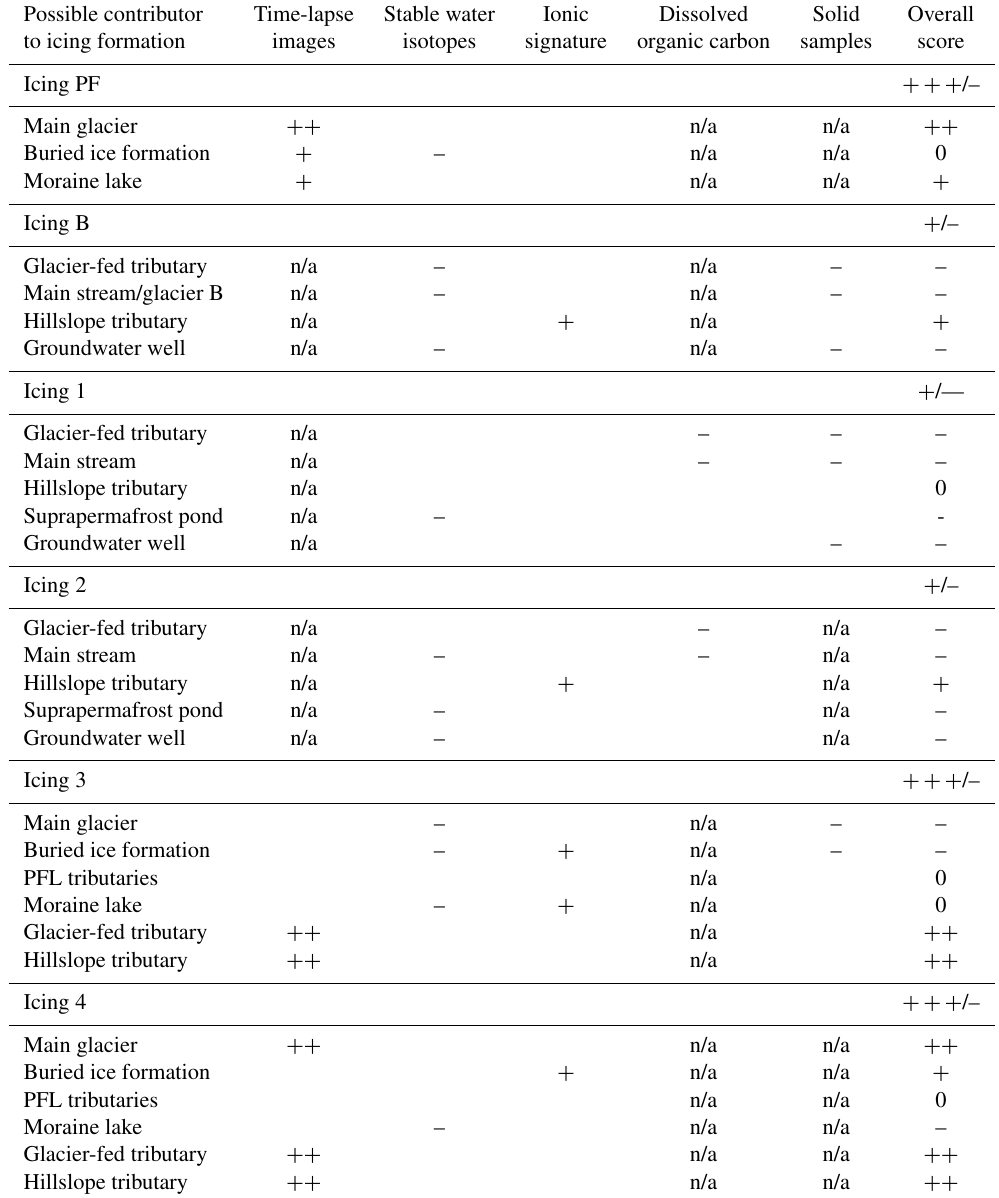
Table 2. Summary of potential contributors to icing formation. Possible